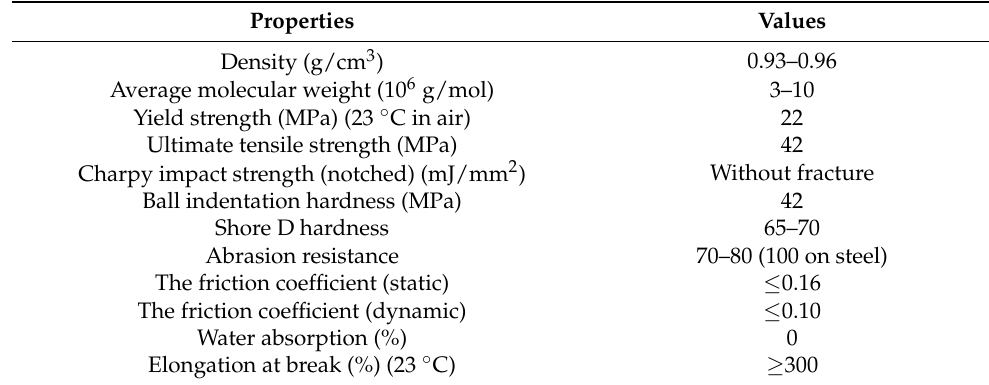
Table 12. The properties of the materials fabricated by ‘Tangyin Dingyuan Engineering Plastics Co. Ltd.’ [50].